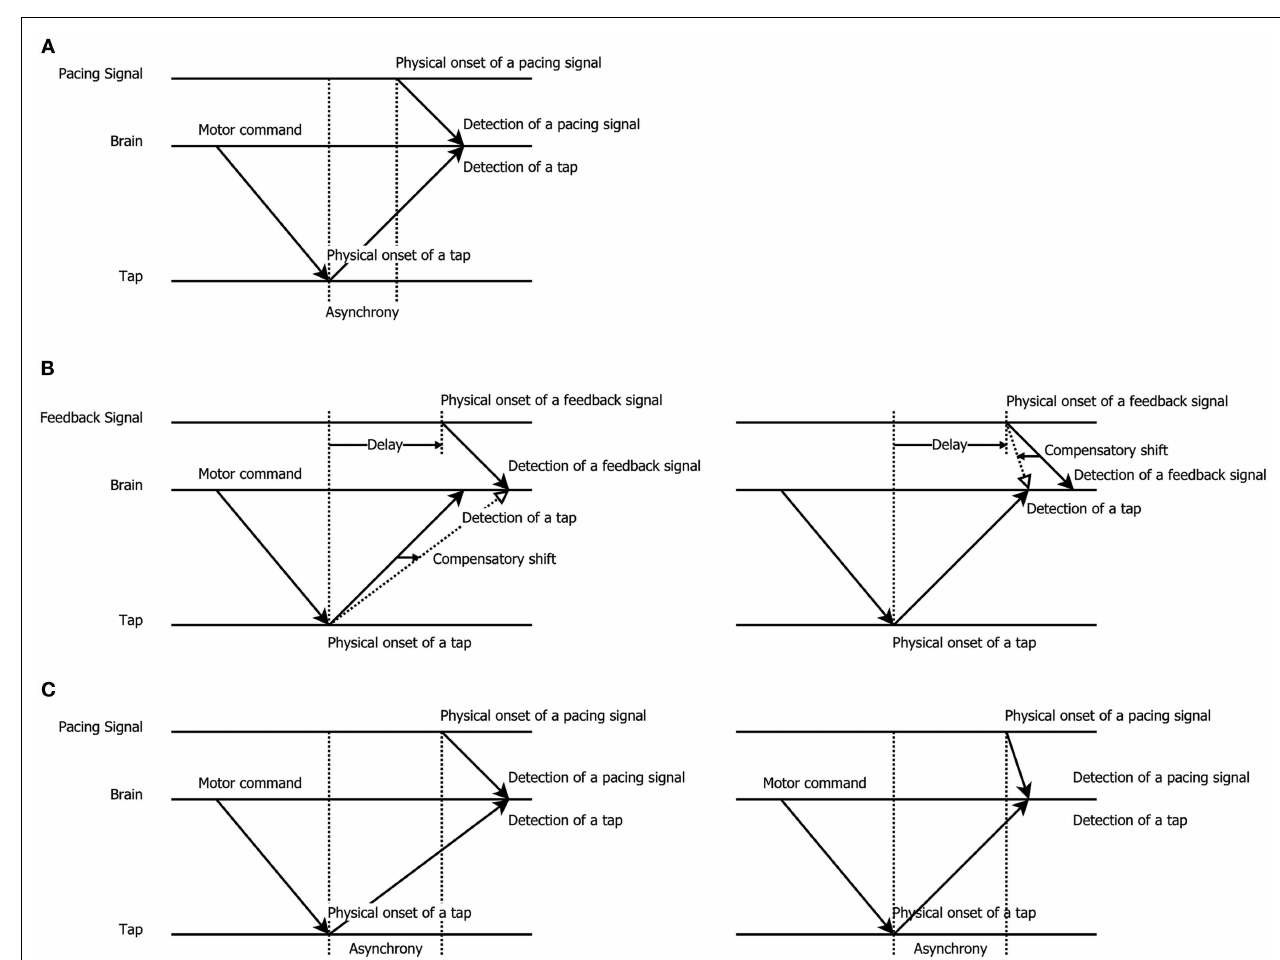
feedback : to re-align the delayed external feedback after a voluntary tap participants may shift the representation of when the pad was touched (left panel) or when the pacing signal came (right panel), thus causing adaptation. (C) Synchronous tapping after adaptation : taps are given earlier due to the lingering effect of adaptation to delay that either slowed down the detection of a tap (left panel) or sped-up the detection of the pacing signal (right